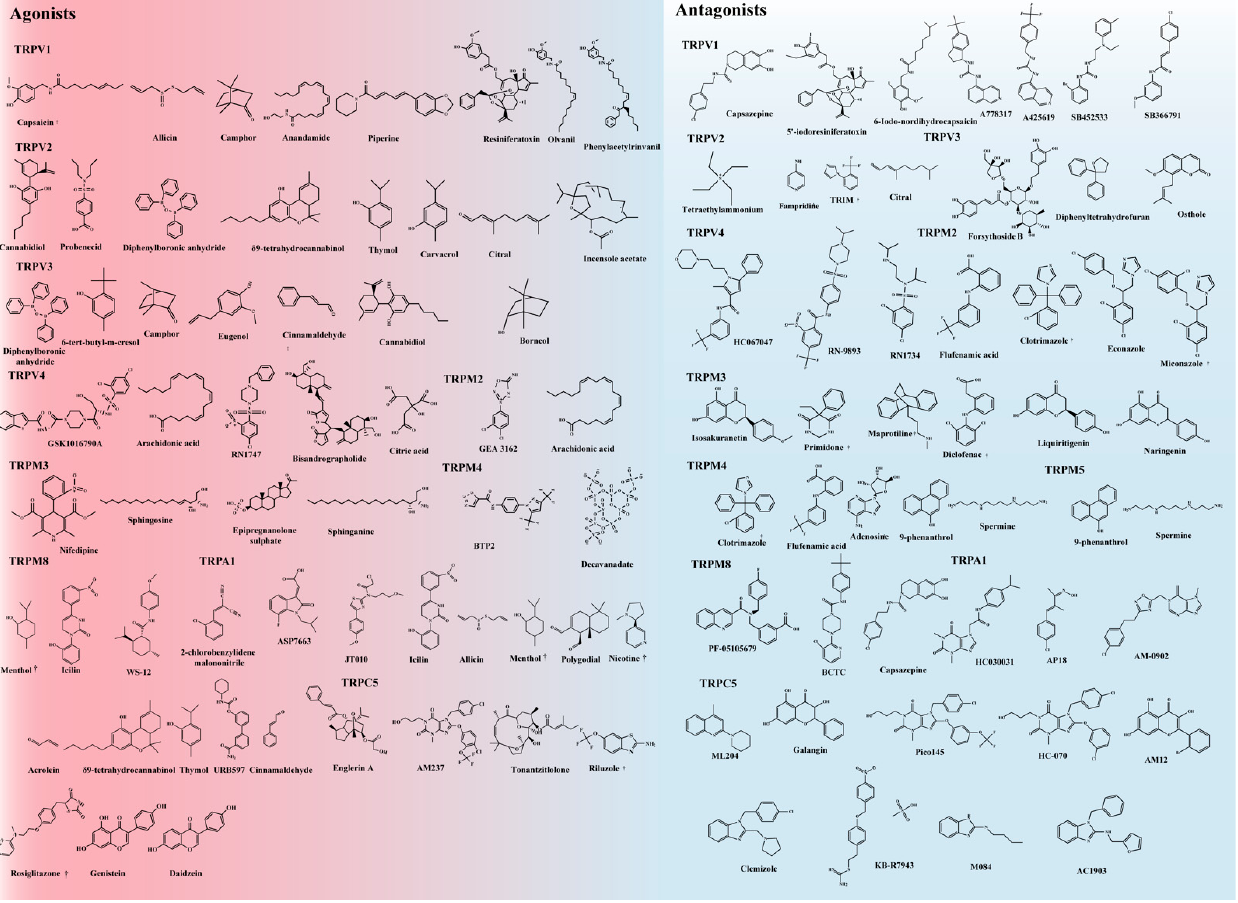
Figure 3. Representative agonist and antagonist structures of thermo-TRPs are approved by the FDA. In Figure 3, the agonists of thermo-TRPs are on the left in the red background, and the antagonists of thermo-TRPs are on the right in the blue background.